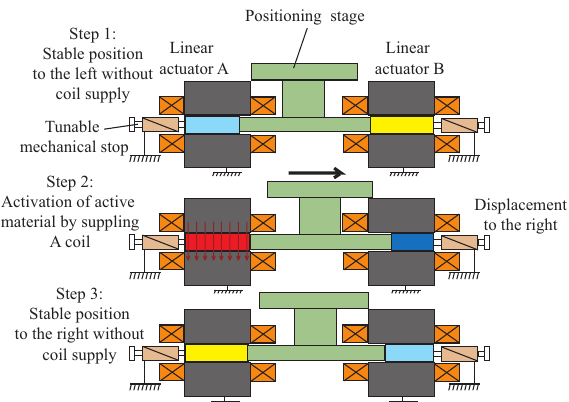
Figure 5: Description of the push-pull configuration of an actuator using two antagonist MSMA samples.